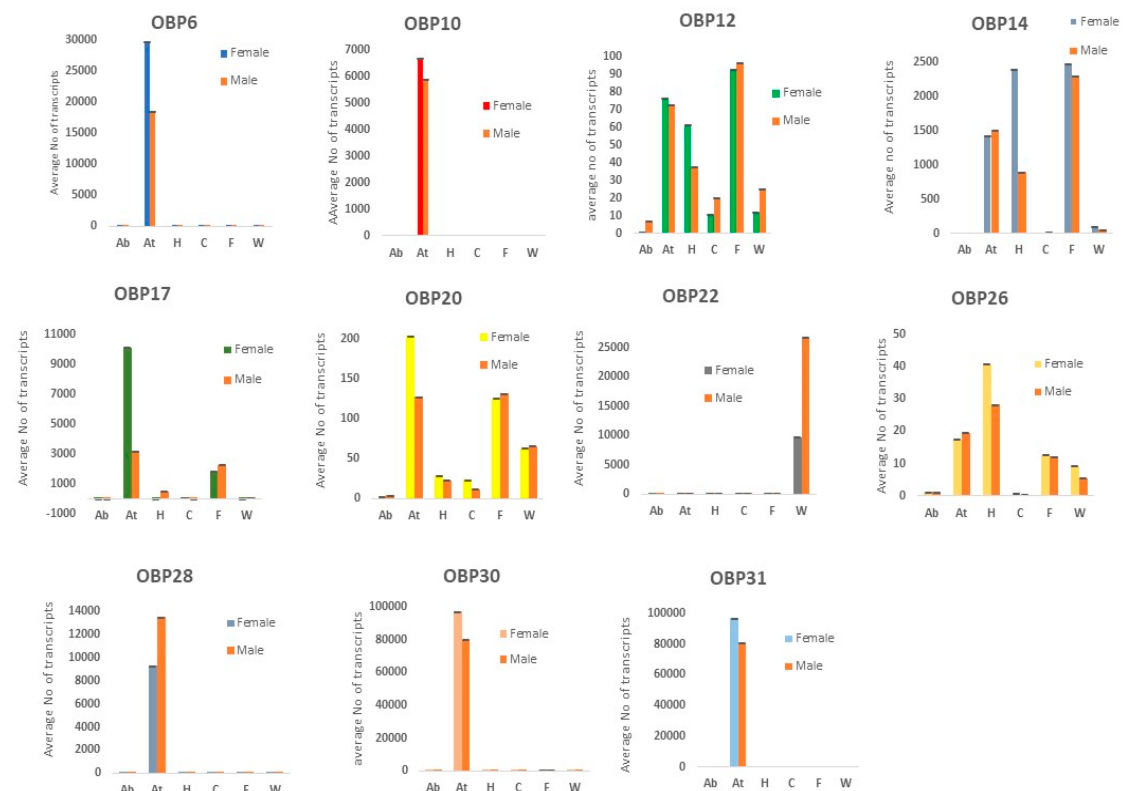
Figure 6. Relative expression (average number of transcripts) of 11 OBP genes in different tissues. Relative fold changes were normalized to transcript levels in the abdomen tissue. (Ab = abdomen; At = Antennae; H = Head; C = thorax; F = legs; W = wing).